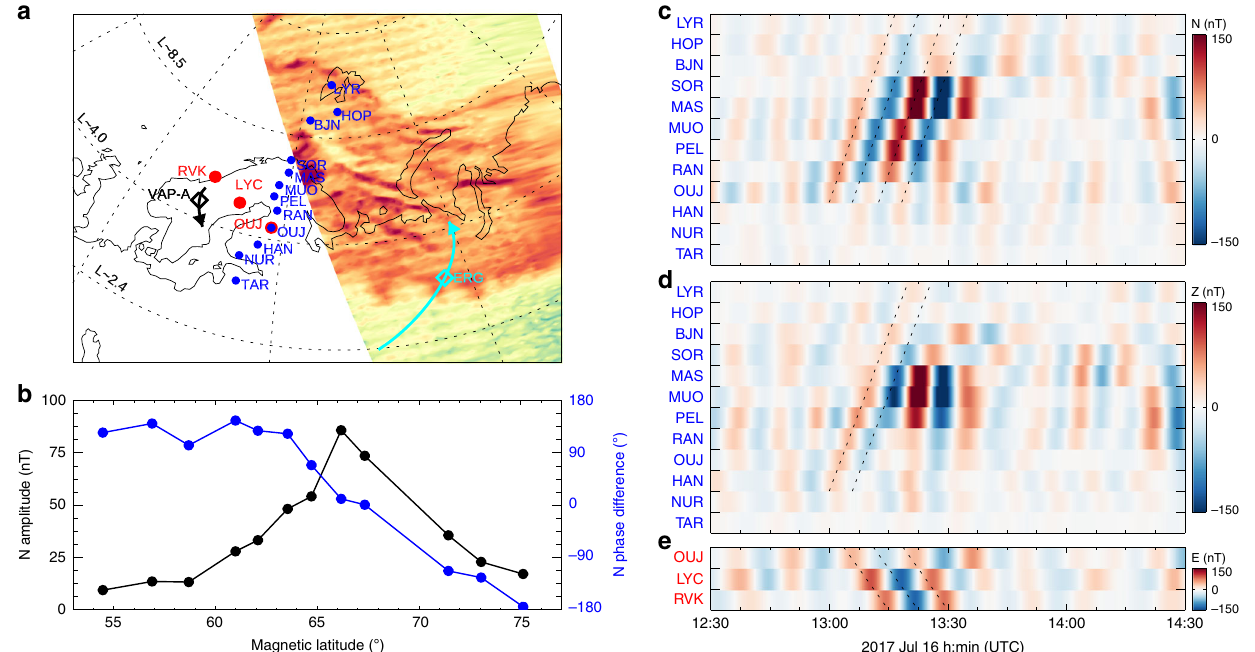
Fig. 4 ULF waves and FLR observed on the ground. a Stations selected from the IMAGE magnetometer array with the background auroral image observed by DMSP F17 satellite at 13:27:45 UTC (see also Fig. 1b). The blue chain is aligned in almost the same magnetic longitudes of ~106 ± 4° with the magnetic latitude increasing from 54.5° at TAR to 75.1° at LYR. The red chain is aligned in almost the same magnetic latitudes of ~61.5 ± 0.5° with the magnetic longitude increasing from 93.3° at RVK to 106.1° at OUJ. The black/cyan arrow represents the footpoints of VAP-A/ERG satellite moving towards low/high latitudes between 13:40 UT and 15:00 UT with the diamond marking plasmapause crossing. b Amplitude (black) and phase difference (blue) of the N component of the blue chain plotted as a function of geomagnetic latitude. c Bandpass fi ltered (1.4 ± 0.5 mHz) N component (north) of the geomagnetic fi eld perturbations. d Bandpass fi ltered (1.4 ± 0.5 mHz) Z component (vertical) of the geomagnetic fi eld perturbations. Clear poleward propagation of the waves is highlighted by the dashed lines. e Bandpass fi ltered (1.4 ± 0.5 mHz) E component (east) of the geomagnetic fi eld perturbations. Clear sunward/ westward propagation of the waves is highlighted by the dashed